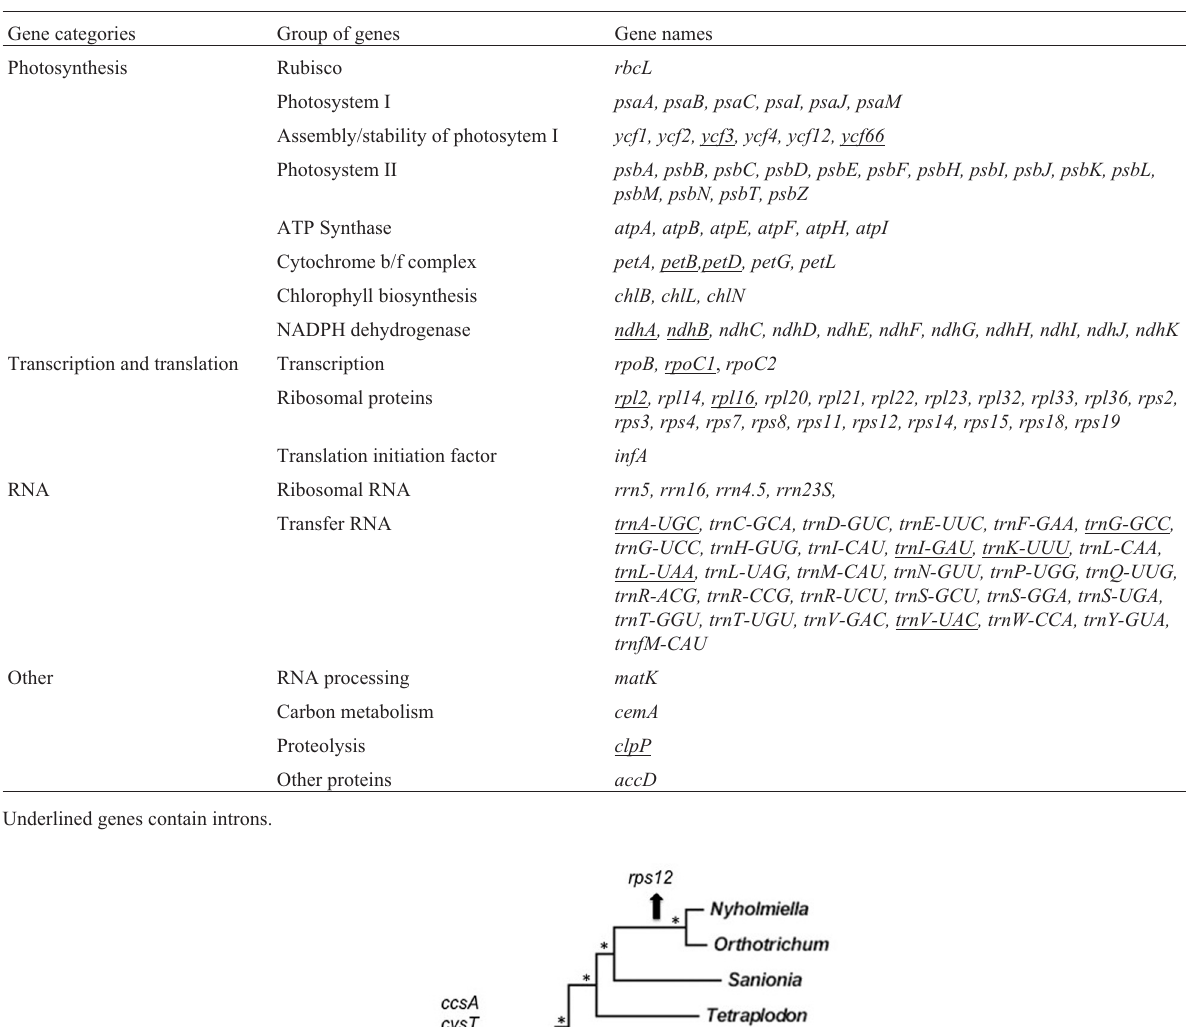
Table 1 - Genes encoded in Pseudocrossidium replicatum